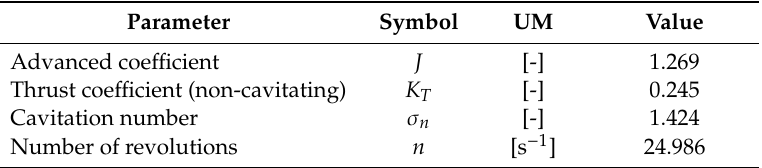
Table 11. Cavitation observations. Test case 2.3.2 in [46].